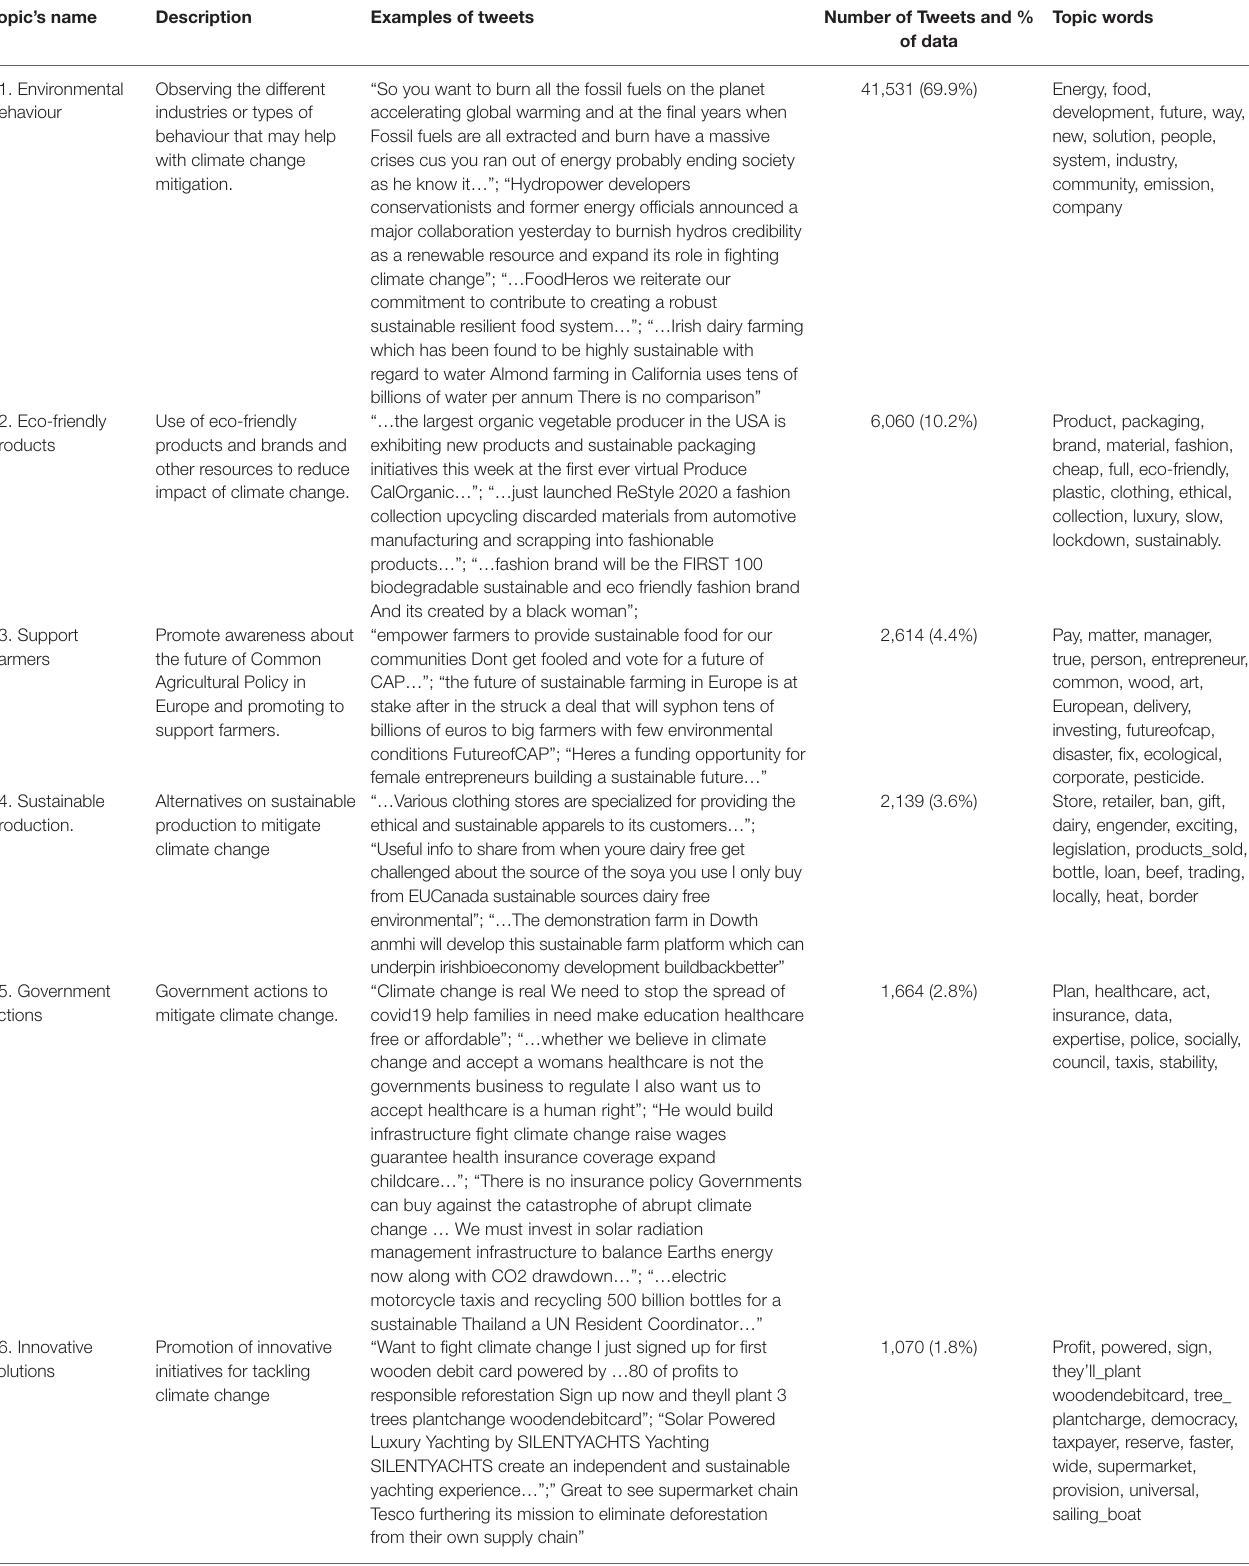
TABLE 7 | Time 3. Labelled topics and topic words within tweets from October